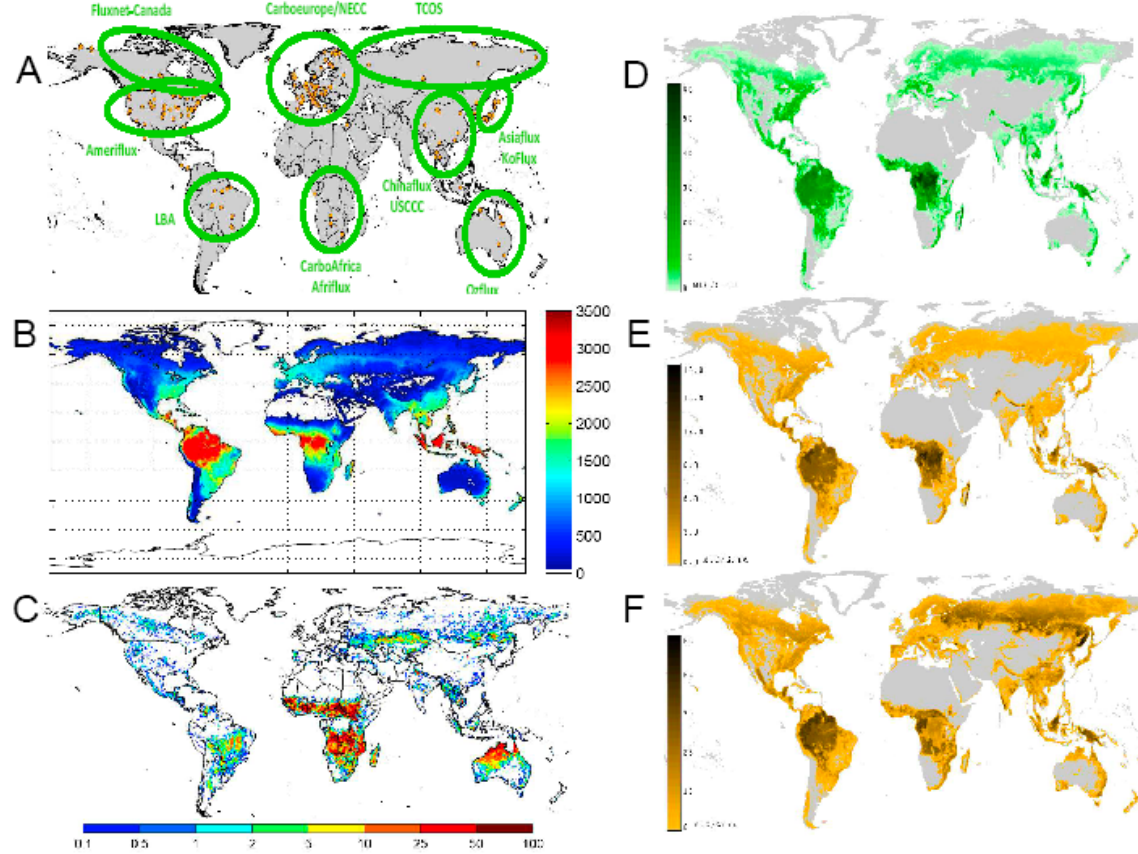
Figure 6. (A) Global network of eddy covariance flux towers in 2010; a larger number of towers exist, but not integrated in the FLUXNET database (http://fluxnet.ornl.gov/fluxnetdb). (B) Example of global distribution of the gross primary productivity obtained by fusion of FLUXNET measurements with global satellite fraction of absorbed photosynthetically active radiation, and gridded climate fields. (C) Global distribution of burned area from EOS-Terra-MODIS. (D) Global distribution of biomass obtained by disaggregating data from FAO reported by each country using satellite observations (http://www.iiasa.ac.at/Research/FOR/biomass.html), (E) below-ground biomass. (F) Soil carbon (from World Inventory of Soil Emission ISRIC-WISE